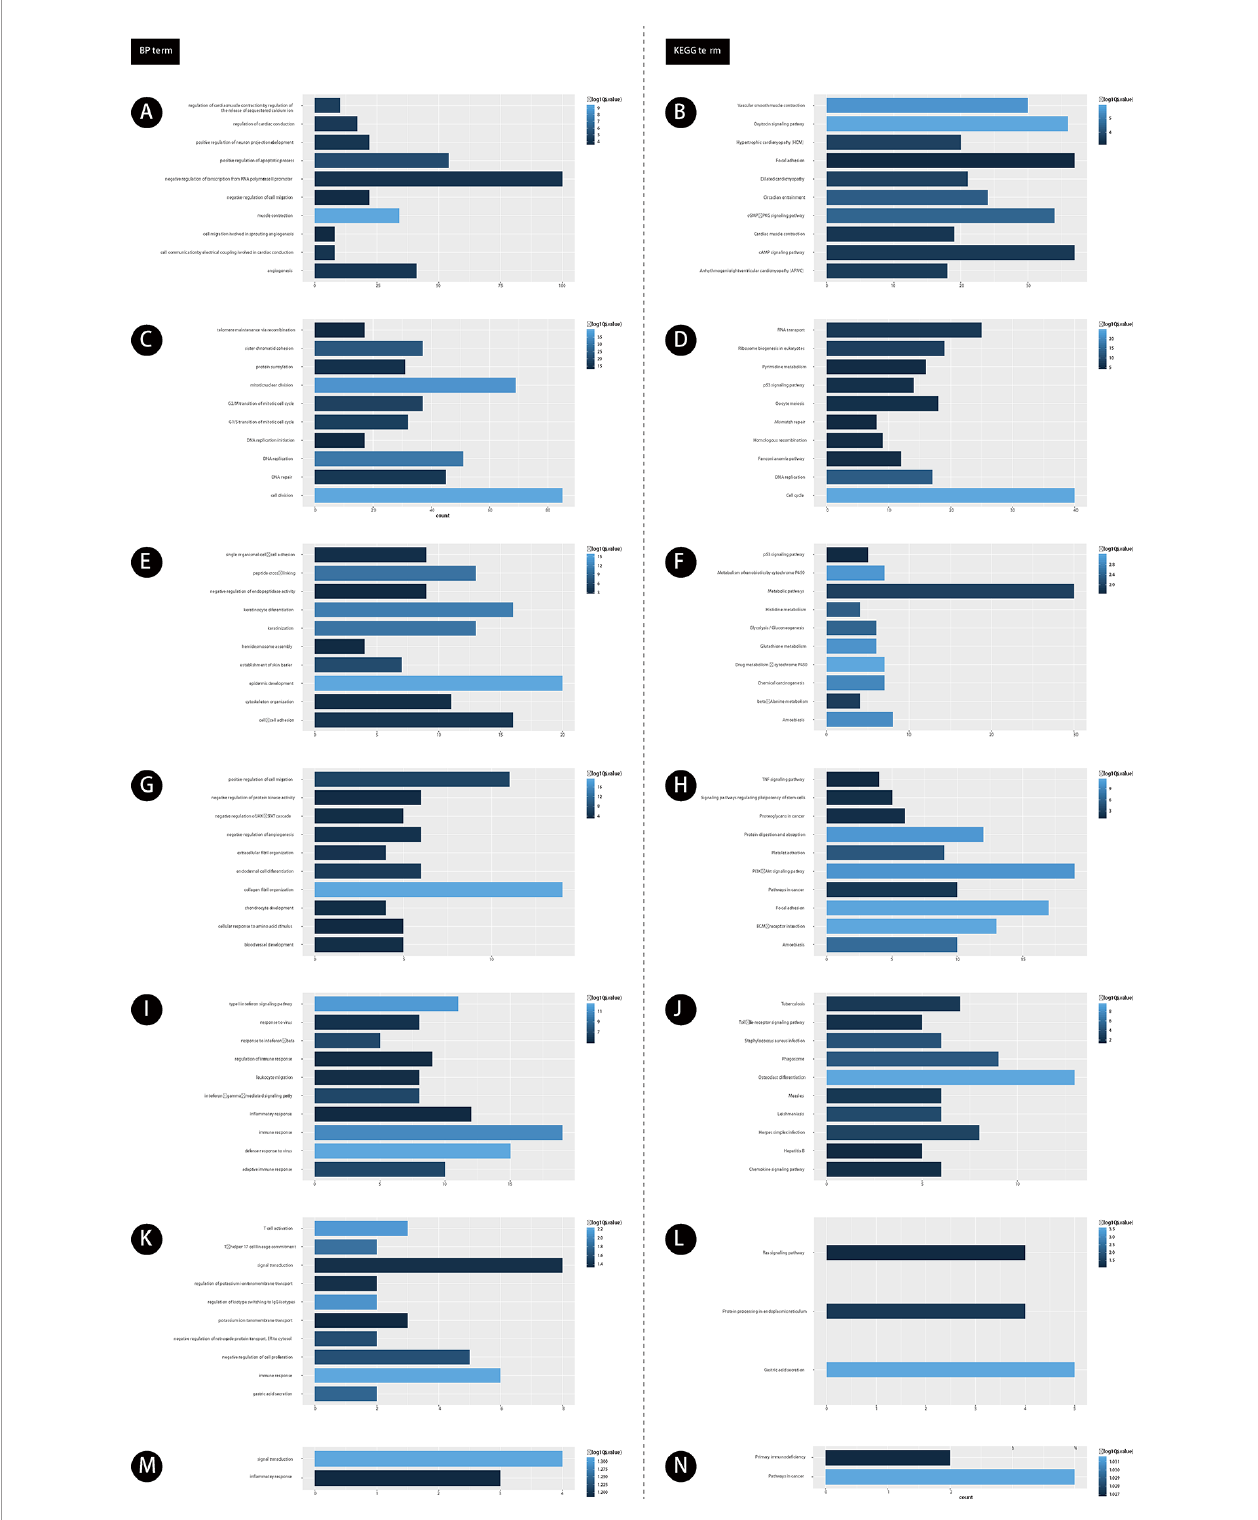
FIGURE 2 | The functional enrichment analysis of genes in module 1-7. (A , C , E , G , I , K , M) GO analysis of gene in modules 1-7. (B , D , F , H , J , L , N) KEGG analysis of gene in modules 1-7. The color depth of histogram represents p -value. The x-axis represents gene counts. The y-axis represents the terms of GO and